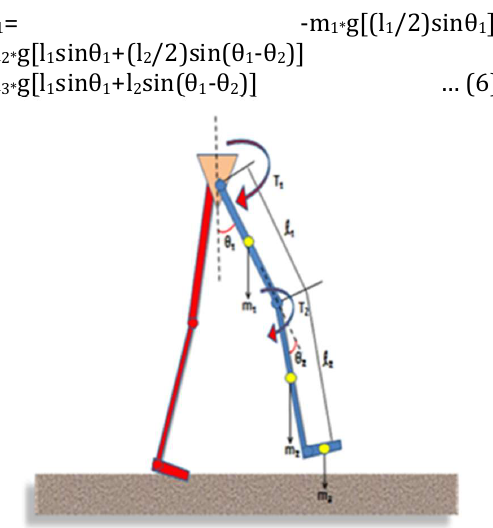
Fig. 6. Swing phase with hip and knee joints